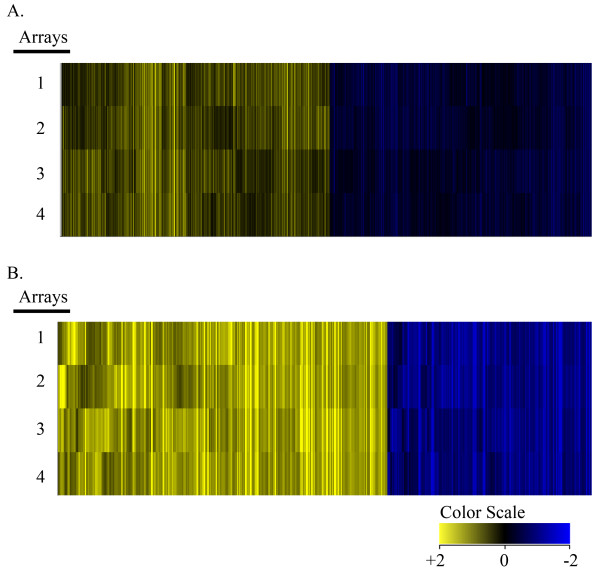
STMN1-/- differentially expressed genes on 2-color microarrays illustrated in heatmaps. (A) Heatmap showing 3953 transcripts filtered with a fold change threshold ≥ 1.2, showing 1997 up-regulated and 1956 down-regulated genes relative to stmn1+/+. (B) 437 transcripts filtered to a fold change level ≥ 2, showing 269 up-regulated and 168 down-regulated genes. Numbers 1 – 4 refer to replicates. Color scale bar indicates up-regulation in yellow and down-regulation in blue.